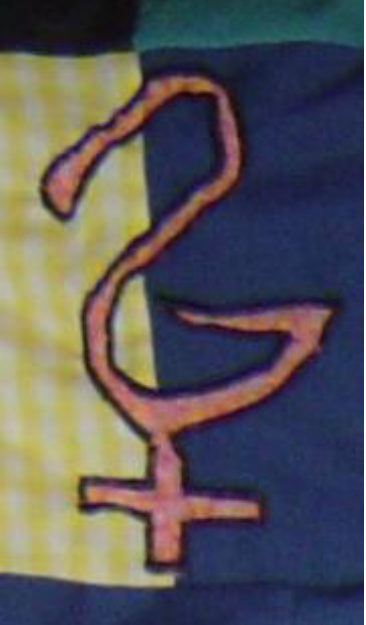
Figure 5. Symbol that represented Gabbie on a student‘s quilt project. The symbol was the student‘s version of Gabbie‘s